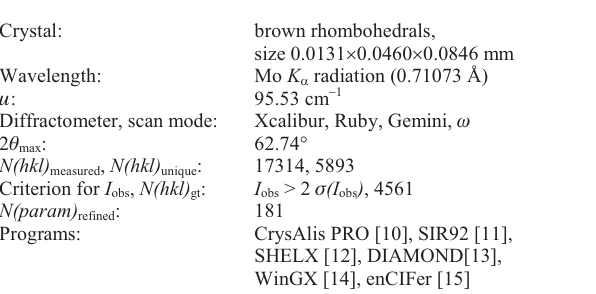
Table 1. Data collection and